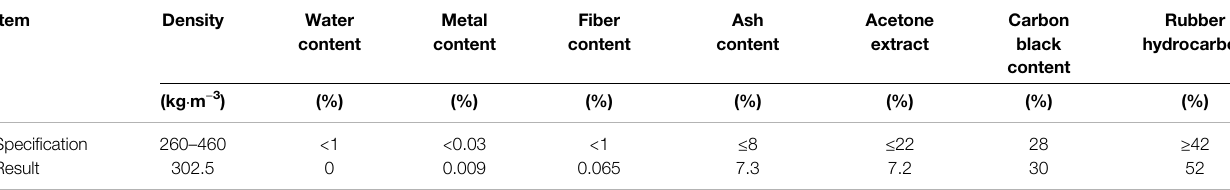
TABLE 2 | Technical properties of CR. Item